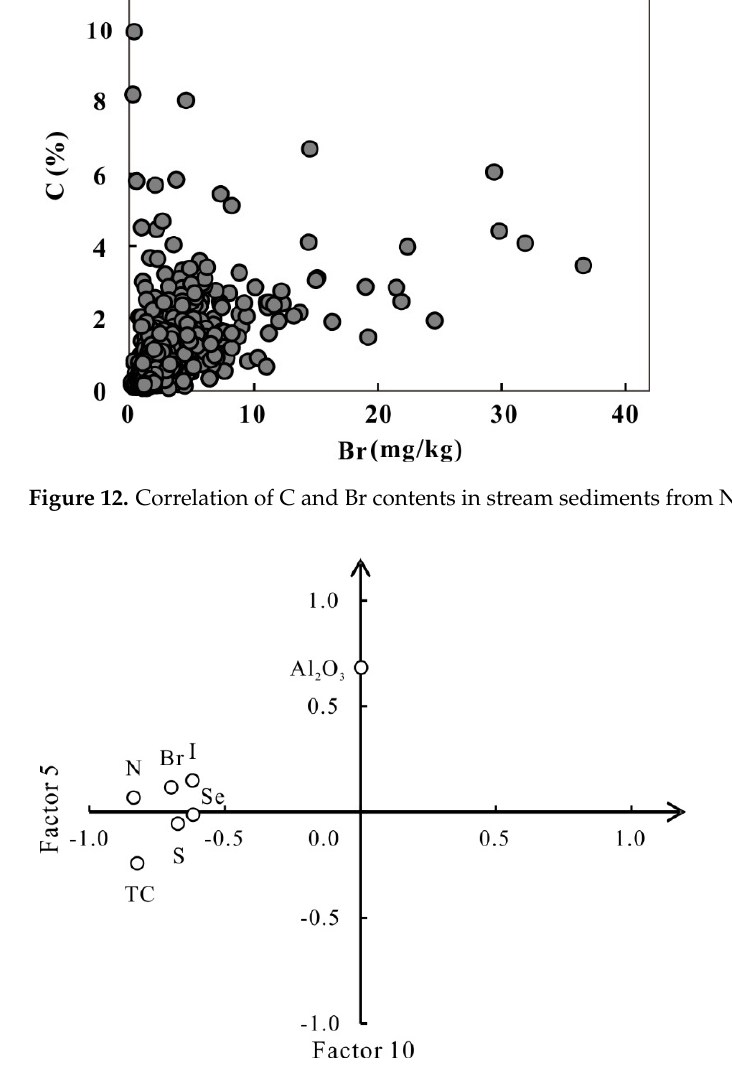
2 O 3 ). Circles indicate